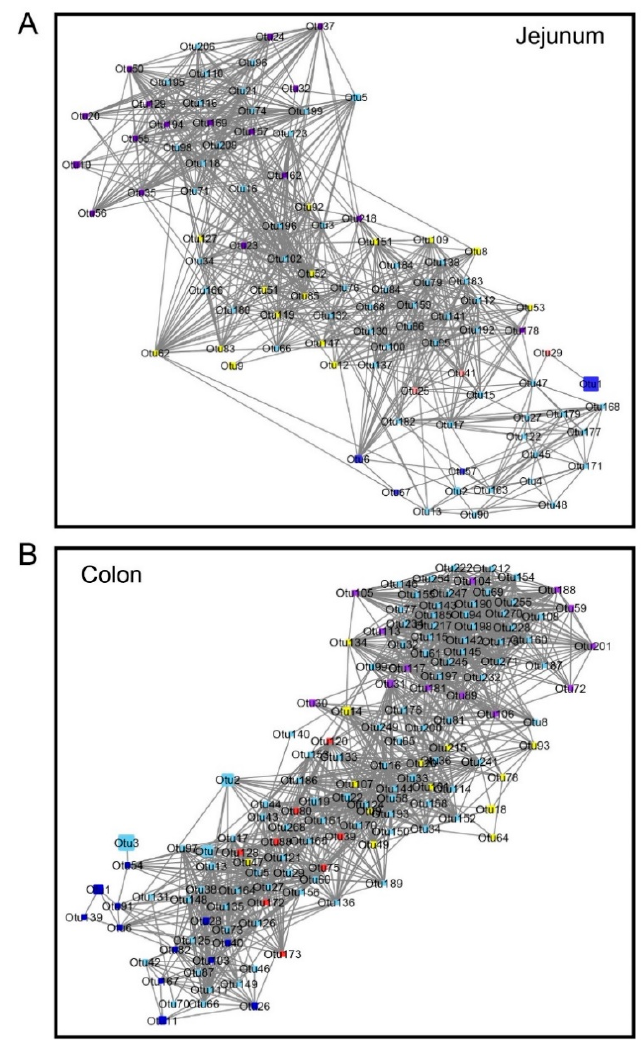
Figure 6. Network analysis. The FASTLSA algorithm was performed to identify the gut bacterial interactions with each age in the jejunum ( A ) and colon ( B ). LSA values greater than 0.6 or less than − 0.6 were identified as the cutoff values. The size of the squares (OTUs) represents the relative abundances of OTUs temporally. The stage-associated bacteria identified by LEfSe were labeled with different colors: d1–d7: blue; d14–d28: red; d42–d56 yellow; d70–d84 purple; others were light blue color.